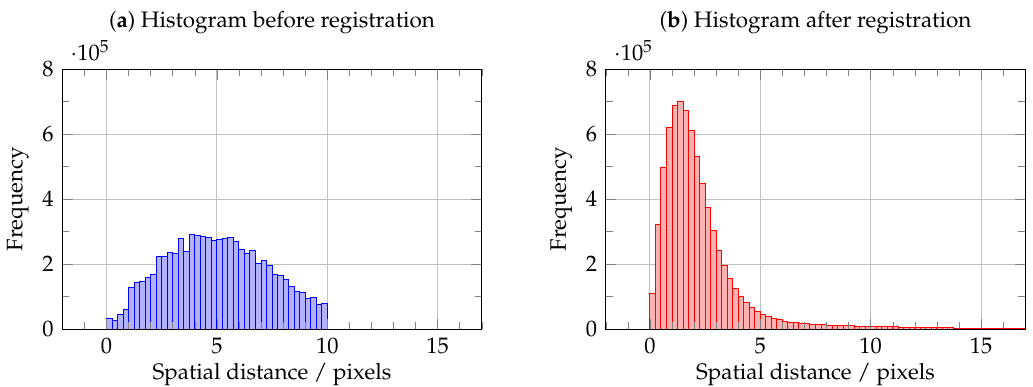
Figure 5. Histograms of spatial distances (in pixels) between the points of matching pairs: ( a ) before applying registration, i.e., as they are originally located; and ( b ) after applying registration, i.e., after transforming the distorted points into registered points with the model described in Section